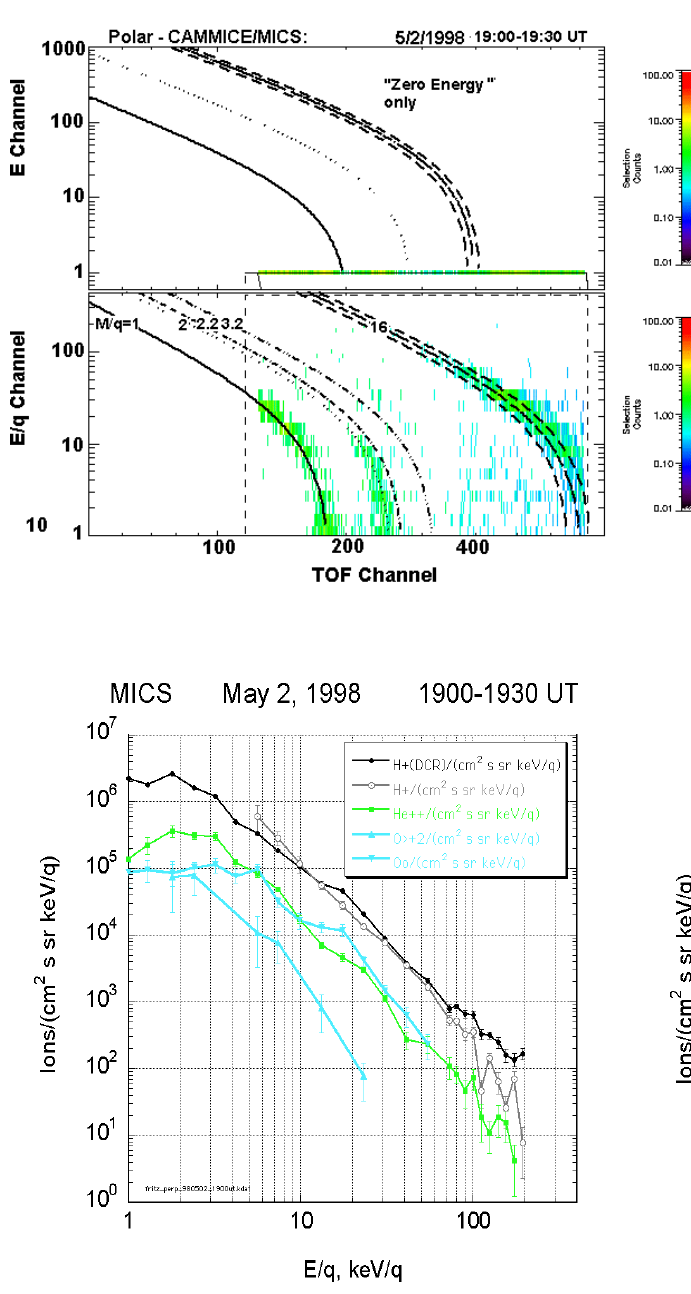
Fig. 7. The energy spectrum of flux versus energy/charge of the four major ion species determined for the interval from 19:00UT to 19:30UT on 2 May 1998.